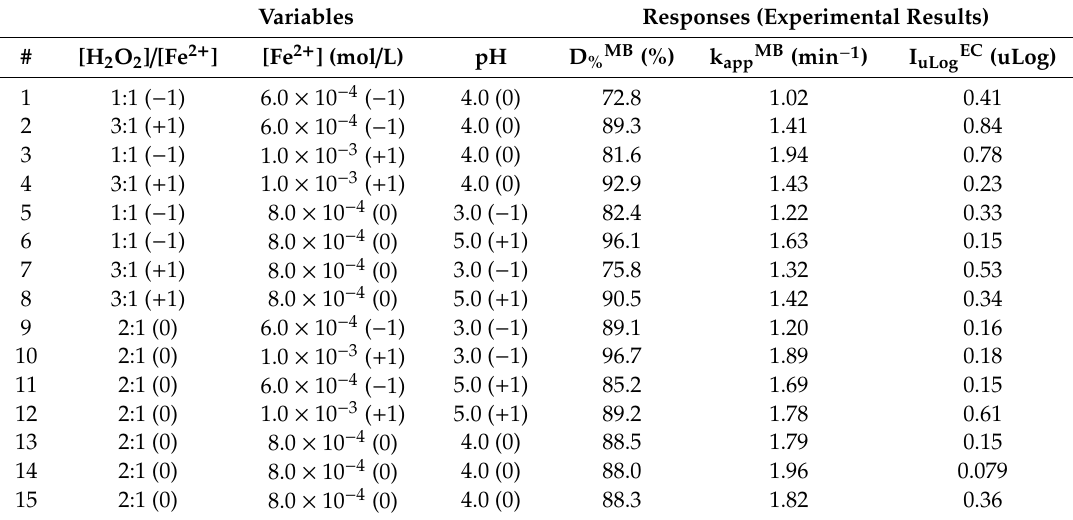
Table 1. Actual values and coded levels (in parentheses) of the variables in the Box–Behnken design and experimental values for each